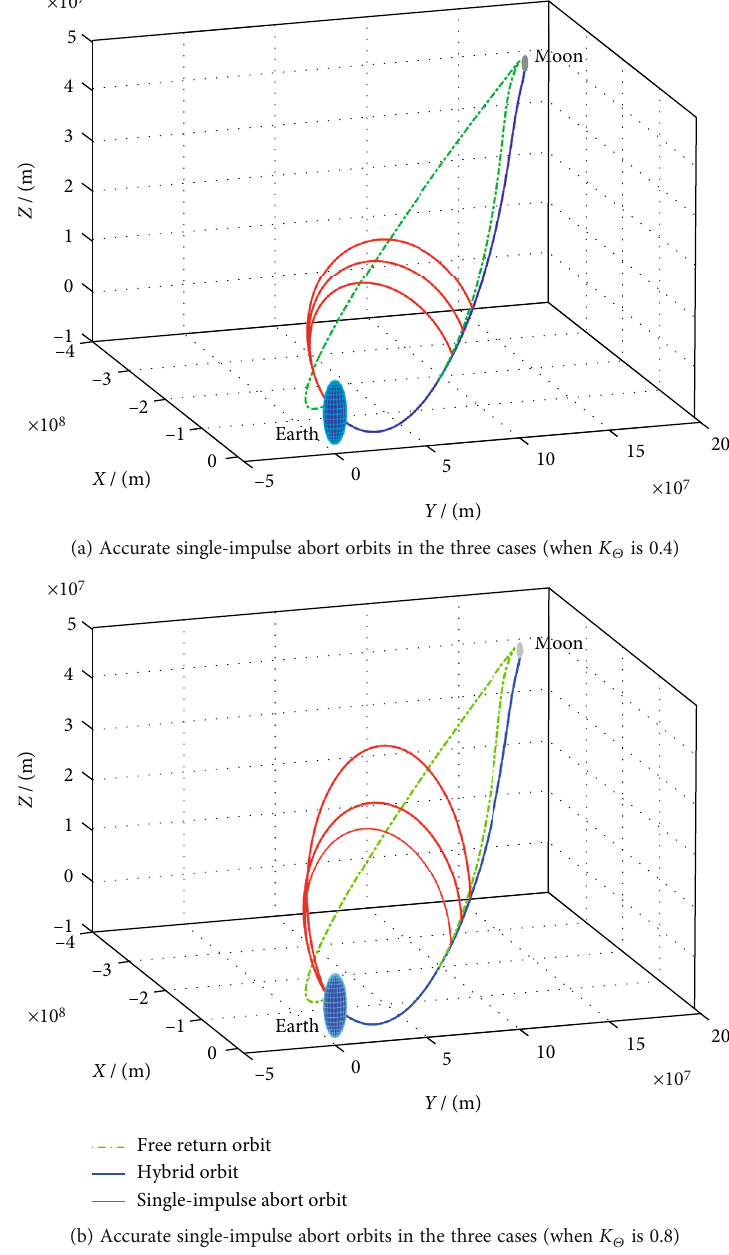
Figure 4: Accurate single-impulse abort orbits in the three cases of two simulation